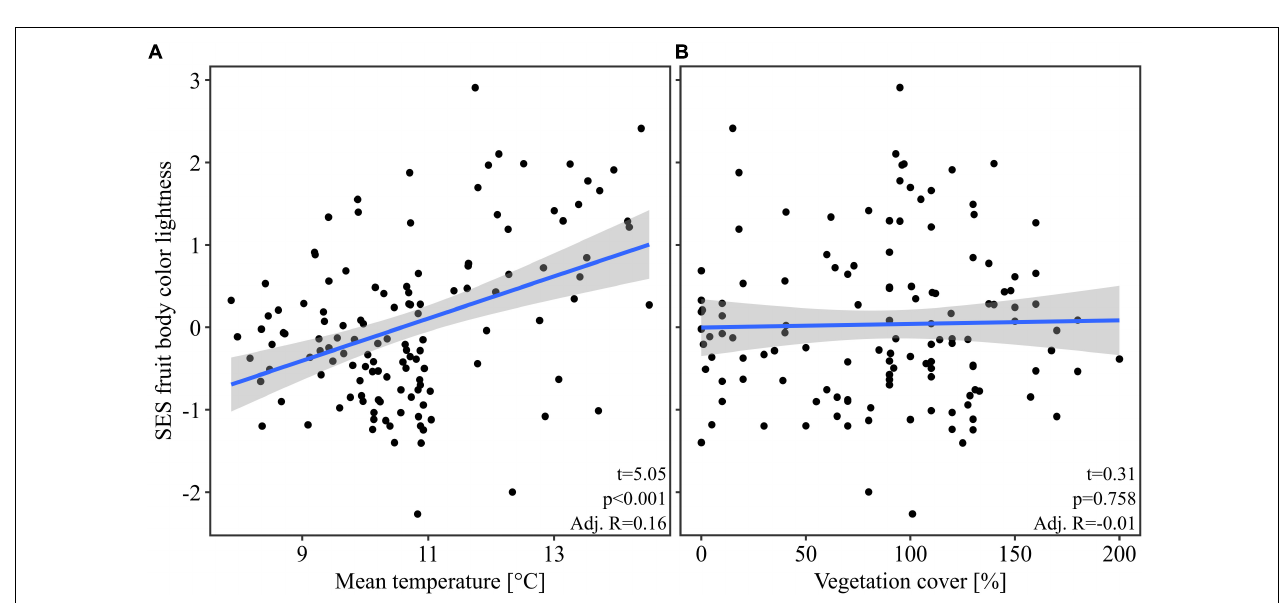
FIGURE 2 | Response of the assemblage fruit body color lightness. (A) Response of the assemblage fruit body color lightness with the mean temperature. (B) Response of the assemblage fruit body color lightness with the vegetation cover. The blue line indicates the univariate linear regression line with the standard error of the mean (shaded area). Statistics within plots are from univariate linear models. For multivariate statistics see Table 1 .